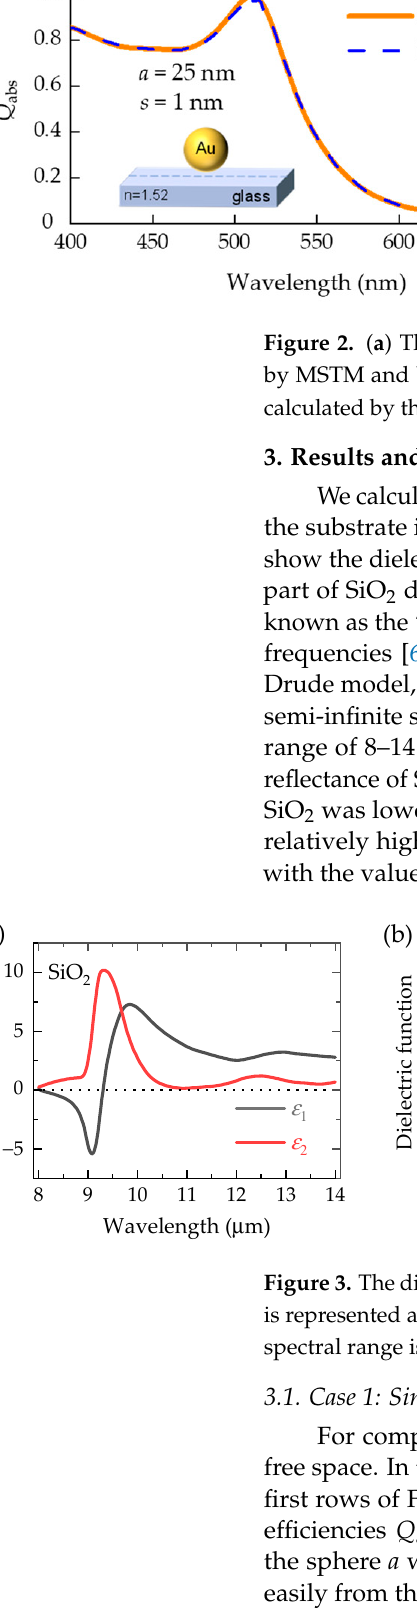
Figure 3. The dielectric functions of ( a ) SiO 2 and ( b ) Al. It is noted that the complex dielectric func- tion is represented as i ε ε ε= + . ( c ) The normal re fl ectance of semi-in fi nite Al and SiO 2 substrates. 1 2 The spectral range is selected for 8–14 µm. from the fi gure that the resonance structures exist in the sca tt ering and absorption e ffi - ciencies. According to the Fröhlich resonance conditions, the dipole resonance of a sphere in air occurs at